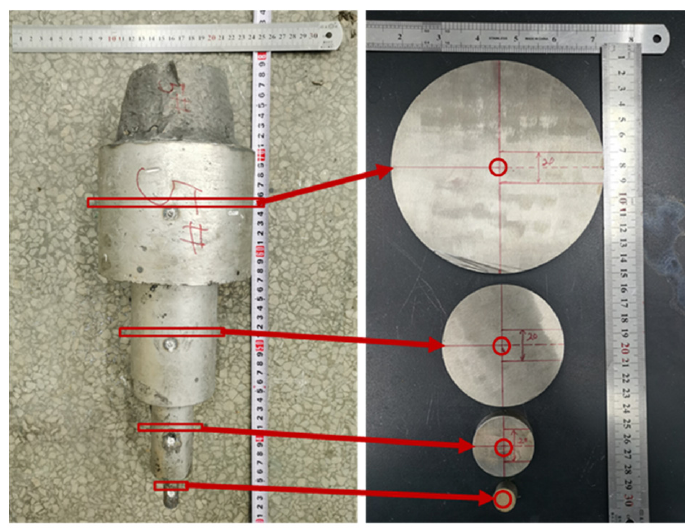
Figure 3. Obtained stepped ingot and sampling location.